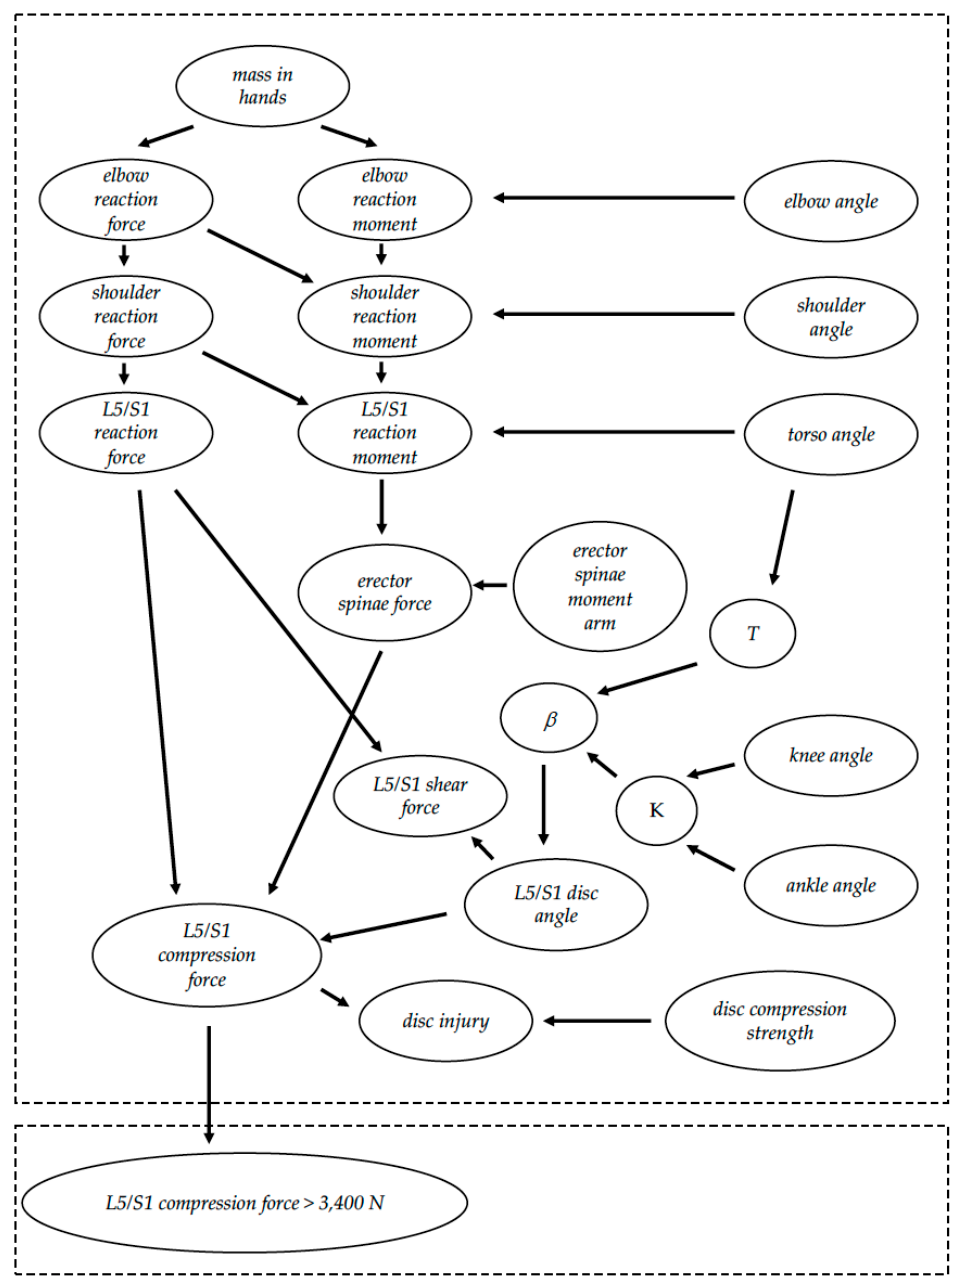
Figure 1. A hybrid Bayesian network developed for computing the probability that L5/S1 compression force exceeds 3,400 N. The upper box (dotted) contains the model developed and described in Hughes [4]. This model was developed using steps two through five of the proposed method. The bottom box (dotted) contains the extension made to make this model directly address the “more likely than not” standard used in civil litigation (step six of the method). The Boolean random variable L5/S1 compression force > 3,400 N was added to extend the model, and it takes on the value of true when the variable defined by the node L5/S1 compression force > 3,400 N and it is false otherwise.